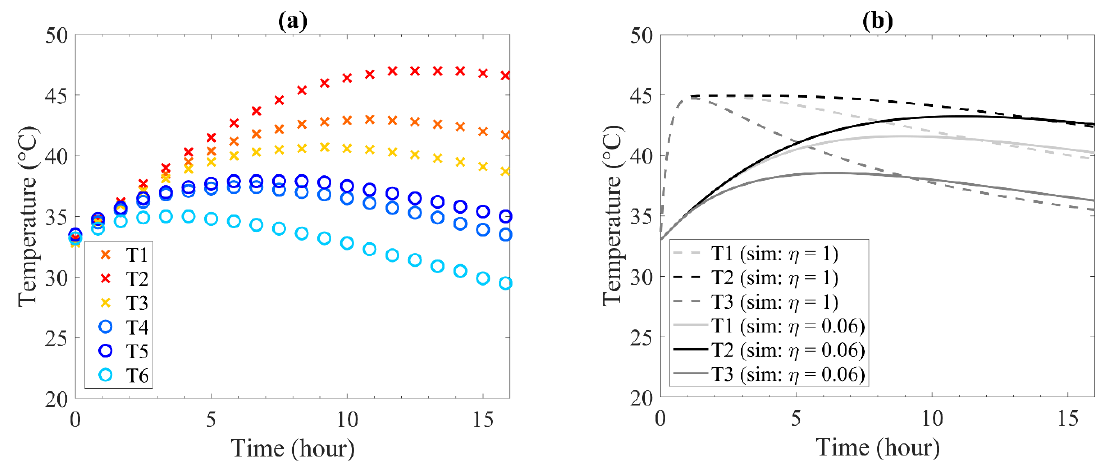
Figure 4. Temperatures as a function of time at different locations in the container (Conditions: T 0 = 33 °C, T ambient = 25 °C, 𝜌 = 200 kg m − 3 , H container = 1 m): ( a ) Experimental results; ( b ) Simulation results with and without an effectiveness factor.